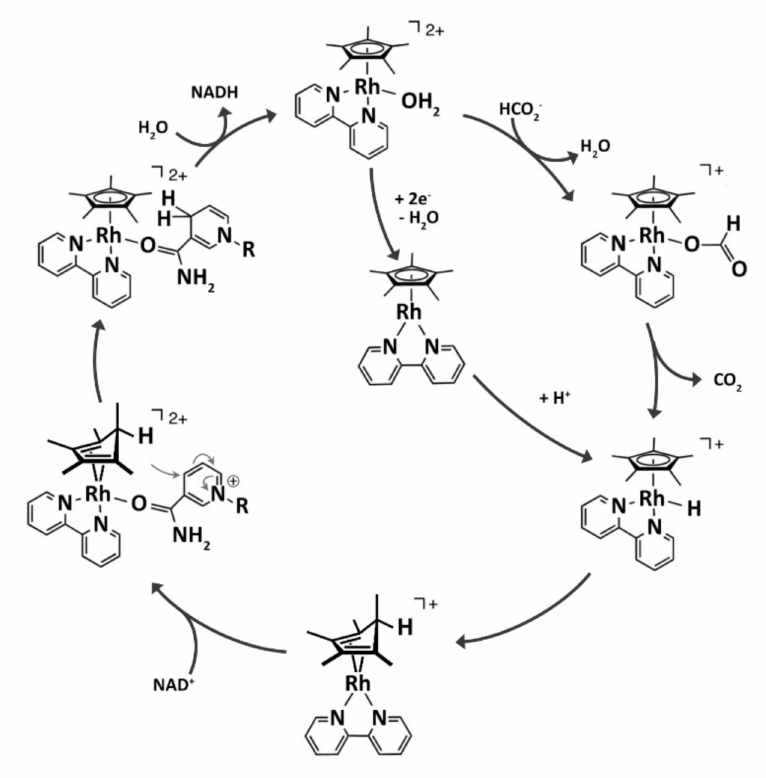
Figure 4. Proposed mechanism for NAD + reduction with [Cp*Rh(bpy)] +